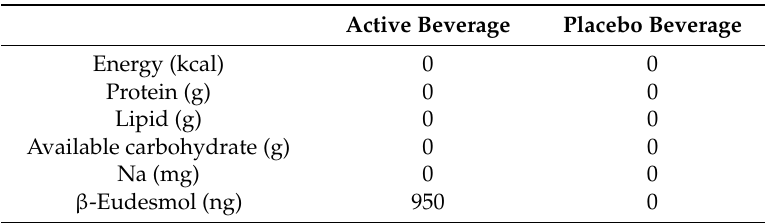
Table 1. Nutritional compositions of test beverages (per 190